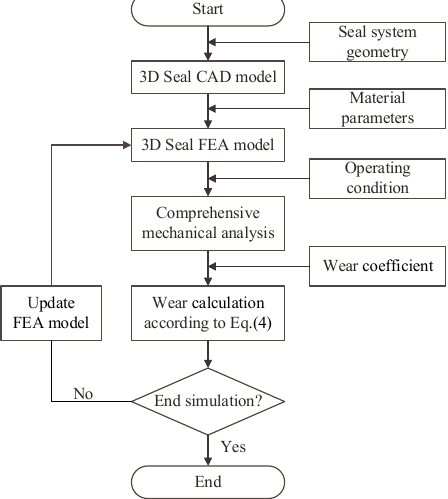
Figure 7. The simulation routine.